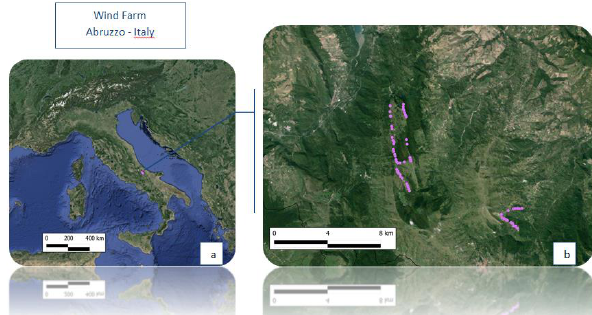
Figure 1. (a) Wind farm in Abruzzo (Central Italy), and (b) turbines layout.